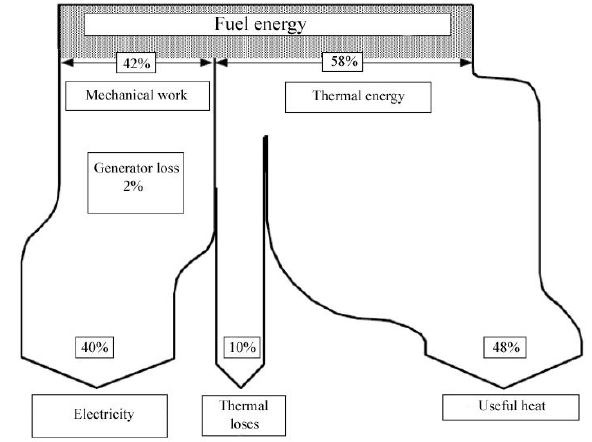
Fig. 1. Energy balance of an internal combustion engine operating in a cogeneration system